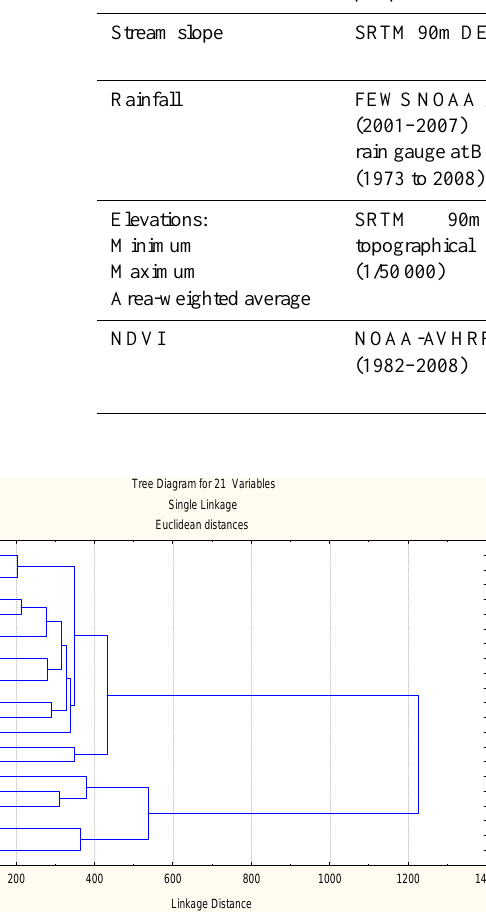
Figure 6 Tree Diagram clustering of Semliki sub-catchments Fig. 6. Tree cluster of the physiographic